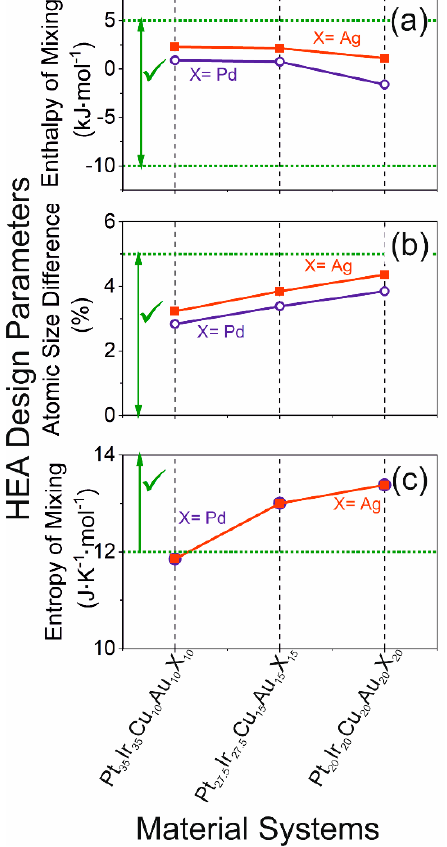
Figure 1. The enthalpy of mixing, the entropy of mixing, atomic size difference for the different configurations of PtIrCuAuX (X = Ag, Pd). The regions marked with “ ✓ ” fulfill the high entropy alloy (HEA) design criteria. The data points are connected to guide the eye.